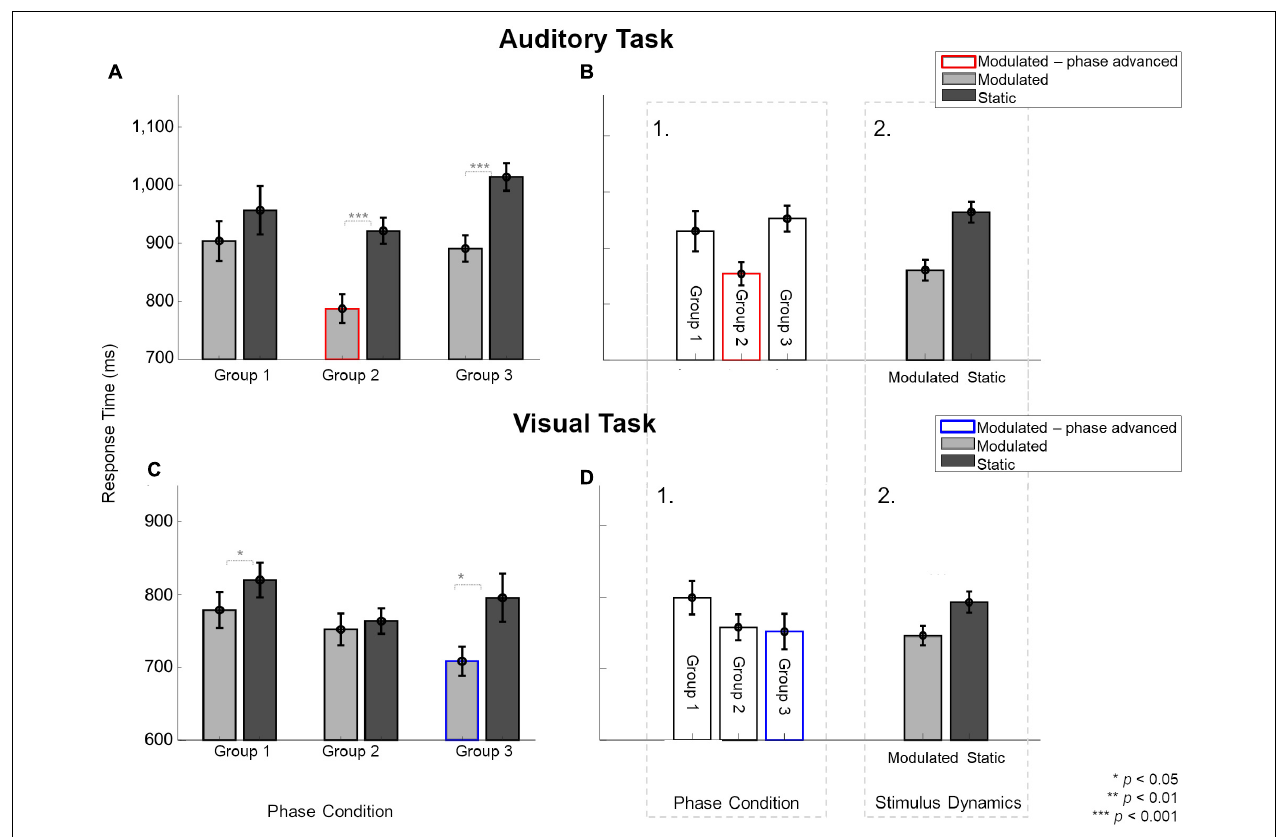
FIGURE 3 | Effect of modulating unisensory stimuli on response times in modulation detection tasks across the three participant groups, averaged over two sessions. Light gray and dark gray bars indicate response times for modulated and static stimuli, respectively. Red and blue borders indicate the modulation conditions with phase shifts. (A) In the auditory task, participants in Group 2 and 3, but not Group 1, were significantly faster to identify modulated than static sounds. Response times to auditory stimuli not only varied between the three groups (B1) but also for stimulus dynamics (B2) . (C) In the visual task, participants in Group 1 and 3, but not Group 2, were significantly faster to identify modulated than static sounds. (D1) Group had no overall effect on response times. Only stimulus dynamics (D2) significantly affected the response times for visual stimuli. Error bars indicate ± 1